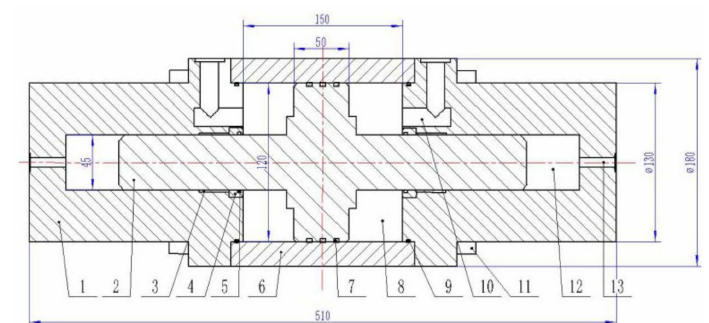
Figure 5. Assembly drawing of the pressurized cylinder. 1—high pressure chamber cylinder;